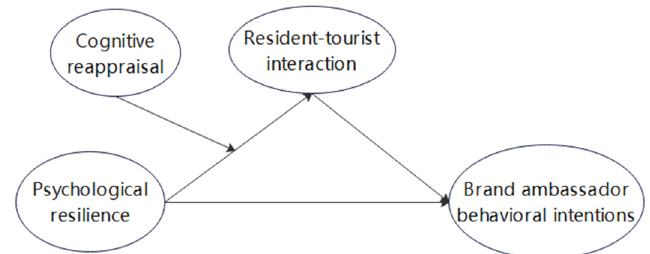
Figure 1. Conceptual framework.